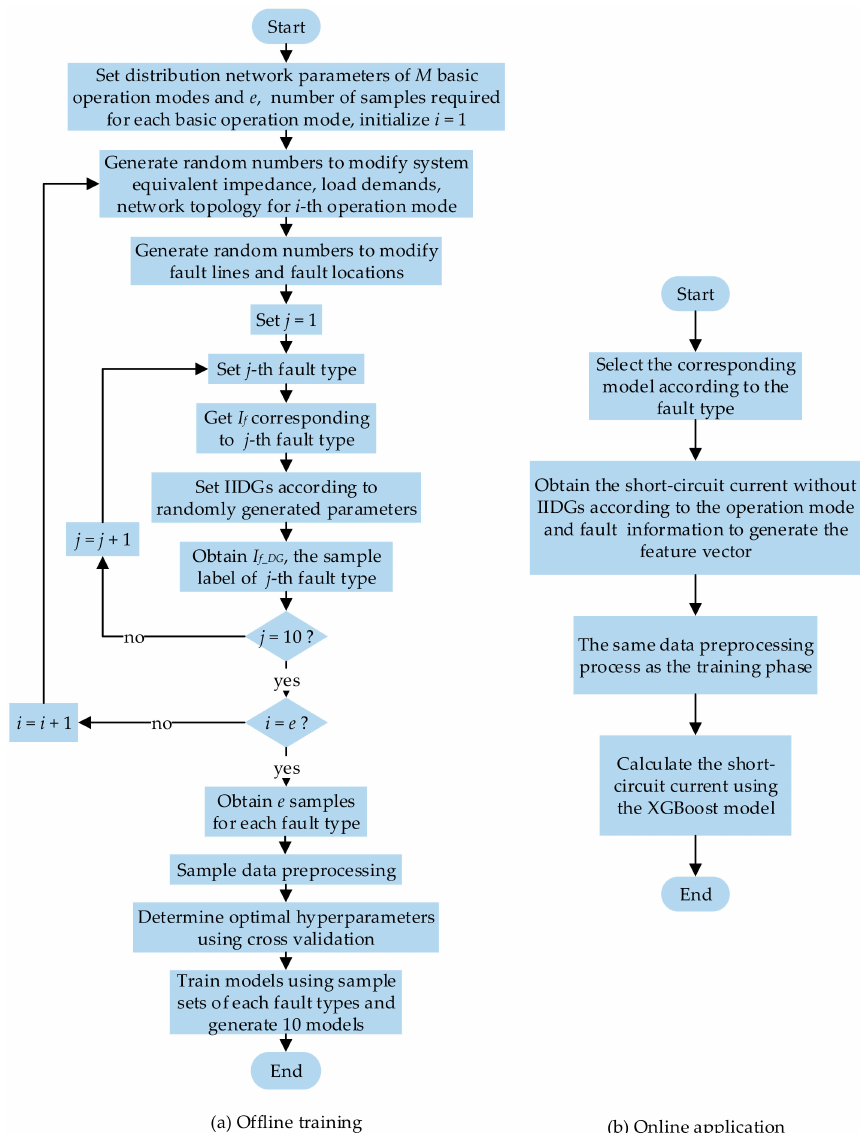
Figure 2. Flowchart of short-circuit current prediction method based on